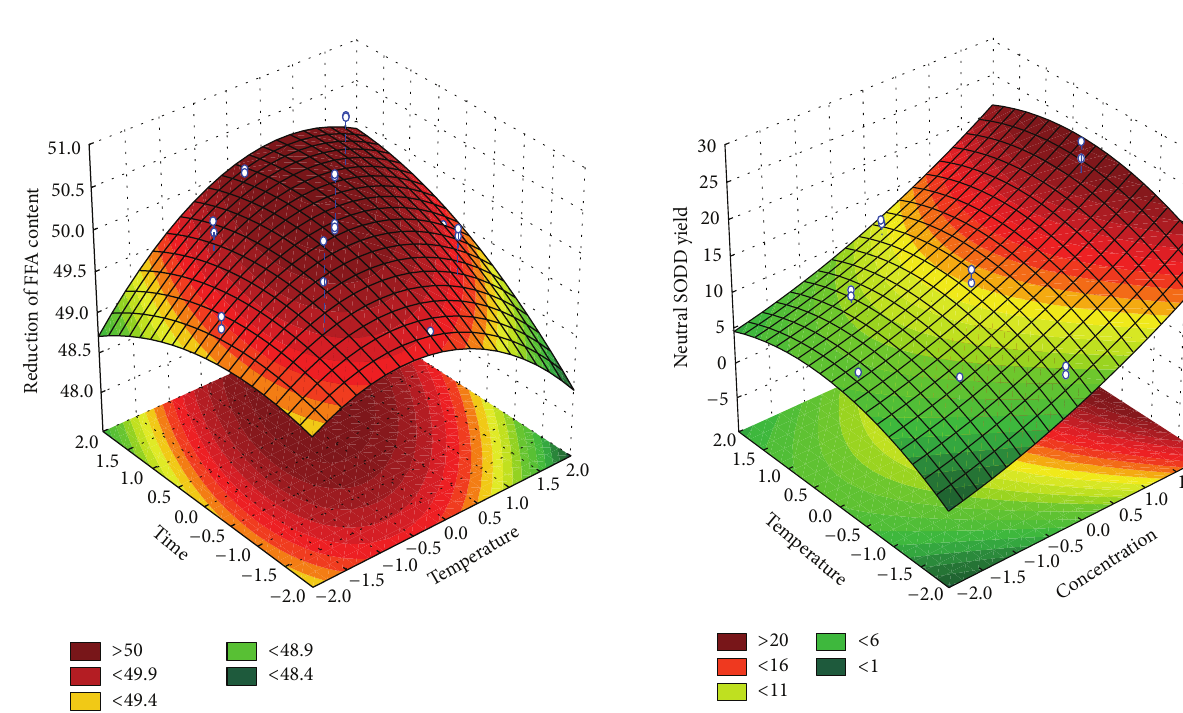
Figure 1: Response surface for the reduction of FFA content in the second experimental design, effects of temperature, and time of reaction (coded values at axis).